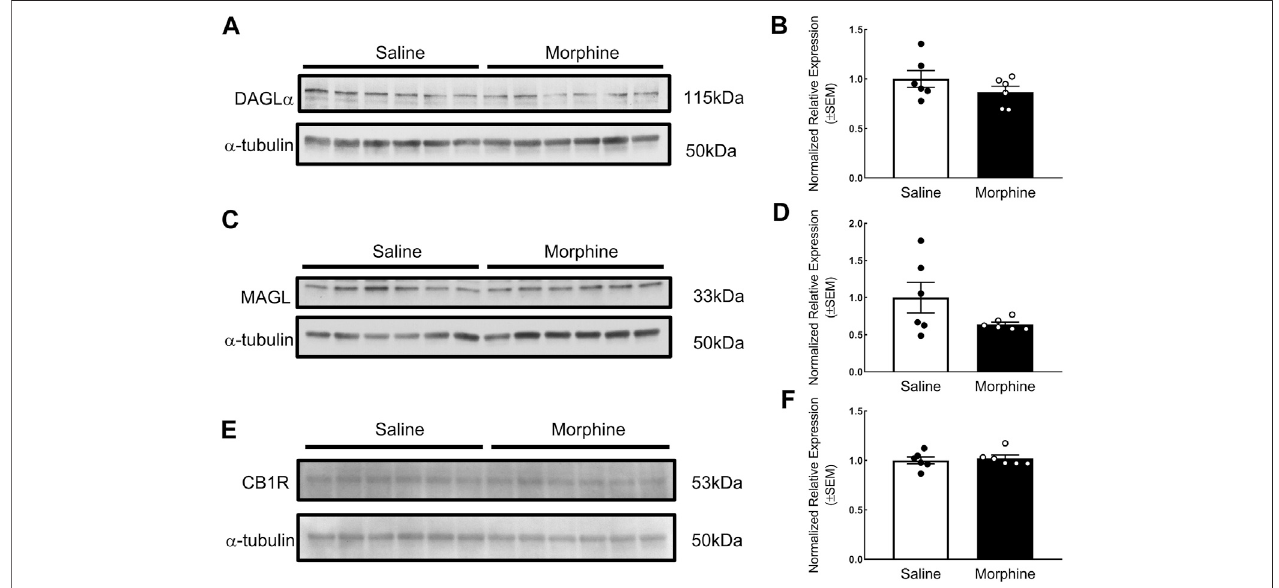
FIGURE 2 | Veri fi cation of the effects of sustained morphine on DAGL α , MAGL and CB1R expression in the VTA. Rats were sacri fi ced after repeated morphine or saline treatment, and the VTA tissues were then collected and prepared for western blot analysis. (A, C and E) Samples were analyzed for the expression of DAGL α , MAGL, and CB1R. (B, D and F) Relative expression levels of DAGL α , MAGL, and CB1R were determined by densitometric analysis and normalized to a -tubulin (as internal control) in each lane. No signi fi cant difference in the expression of DAGL α , MAGL, and CB1R was observed between two treatment groups. Values represent the mean ± SEM, n (cid:1) 6 per